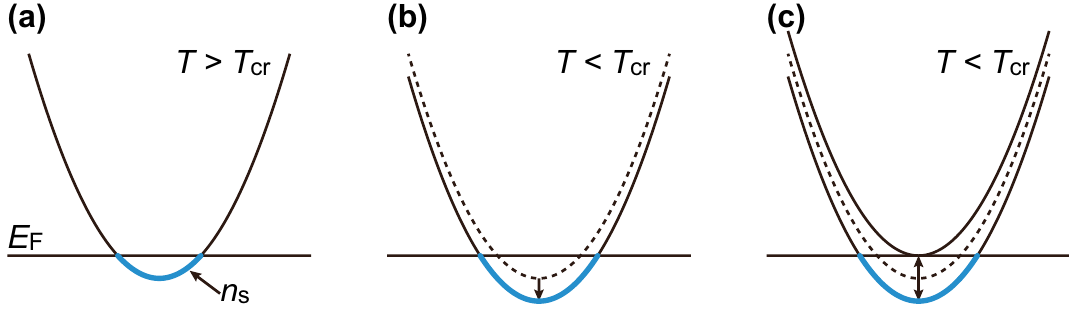
Figure 5. Possible scenarios to increase the carrier density at the S-M transition. ( a ) The E F is pinned on the bottom of the BCB above T cr . The BCB is indicated by the parabolic line in which blue states under the E F are occupied by the electrons. ( b ) The BCB is lowered owing to the expansion of the band width below T cr . ( c ) The BCB is split owing to electron correlation below T cr